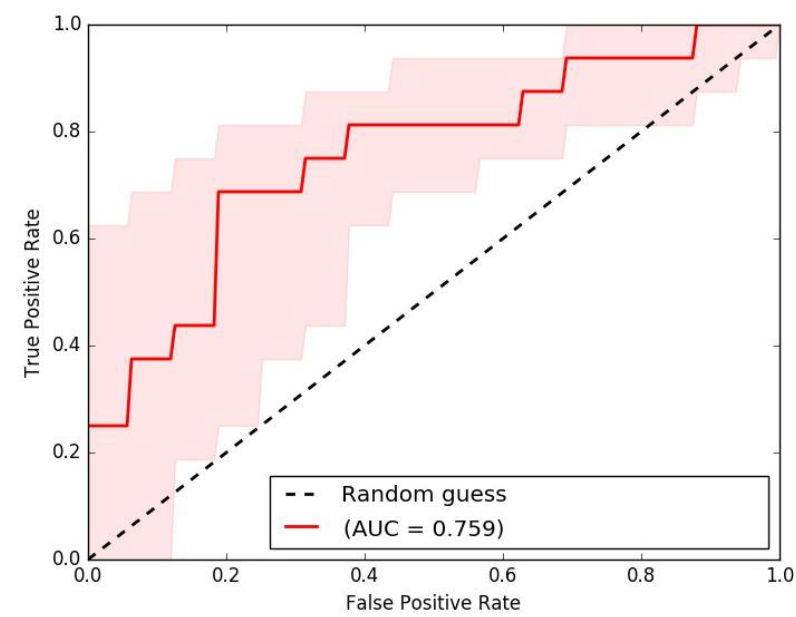
Figure 9. ( a ) Groundwater prospective map of the study area; ( b – d ) Subsets of Landsat 753 band composites display the vegetation in green and water in dark blue color.